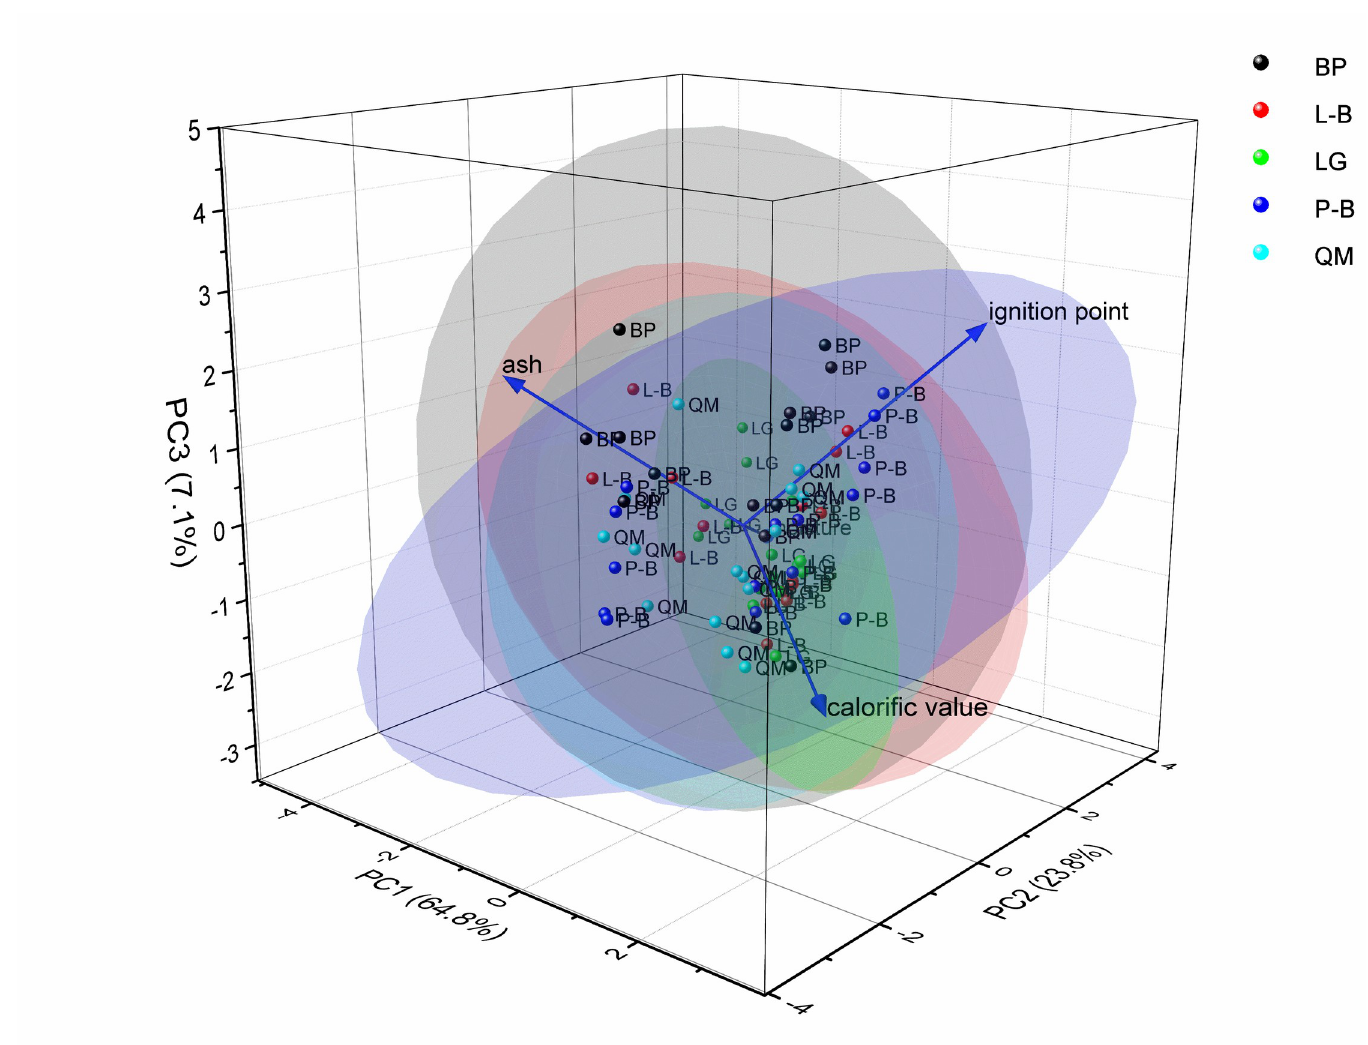
Fig 4. Principal component analysis of each attribute.